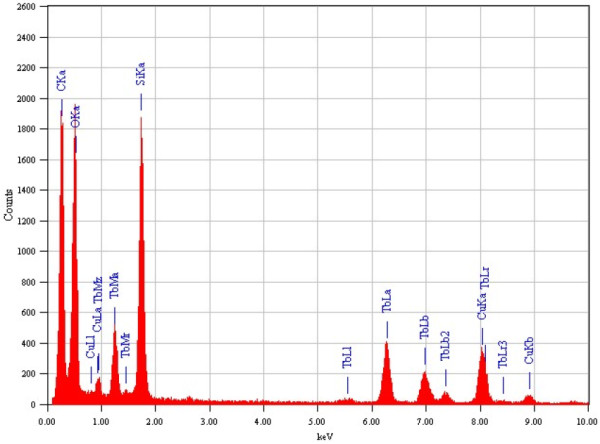
EDX image of the luminescent mesoporous Tb(OH)3@SiO2core-shell nanosphere.